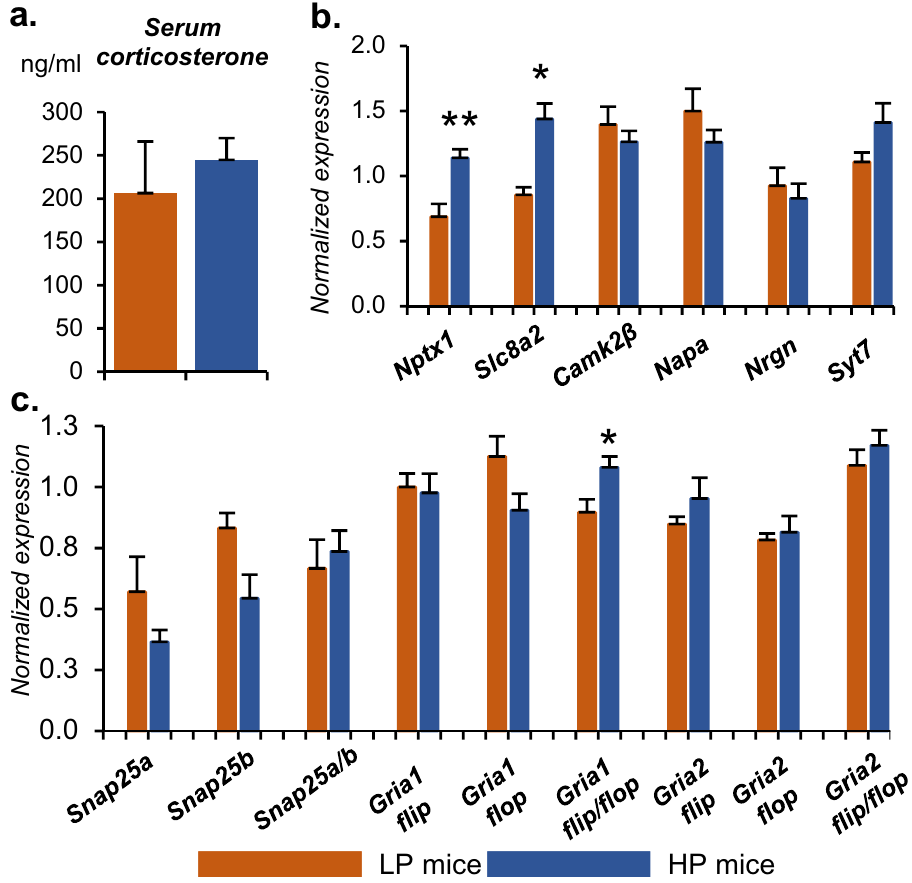
Figure 2. qPCR analysis for validation of DEGs and DASGs. ( a ) Levels of serum corticosterone. ( b ) Relative expression of genes related to synaptic plasticity. ( c ) Relative expression of alternatively spliced transcripts. Data are presented as mean ± SEM ( a – c ), * p < 0.05, ** p < 0.01 as compared to the LP group (Student’s t